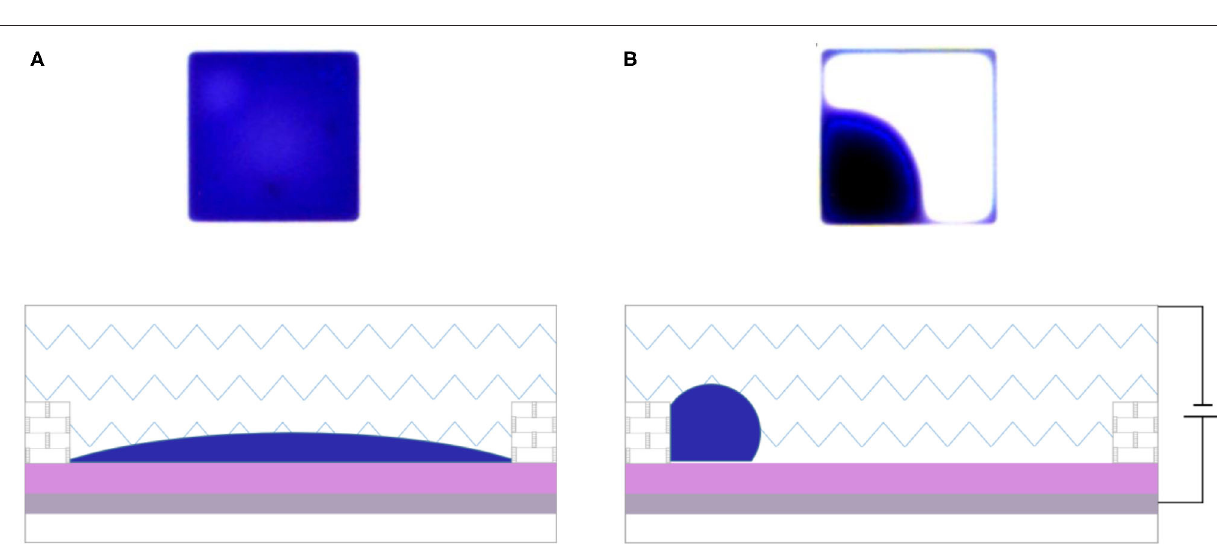
FIGURE 2 | Display principle of an EWD pixel. (A) When the pixel was turned off, the whole pixel was covered by oil, the color of oil was reflected. (B) When the pixel was turned on, the oil was pushed into a corner of the pixel, the color of substrate was reflected. The aperture ratio is a proportion of the exposed white substrate area in a whole pixel. The different aperture ratio represents different optical states. The surface area of oil can be expressed as equation (4), and the aperture ratio can be defined as equation (5)